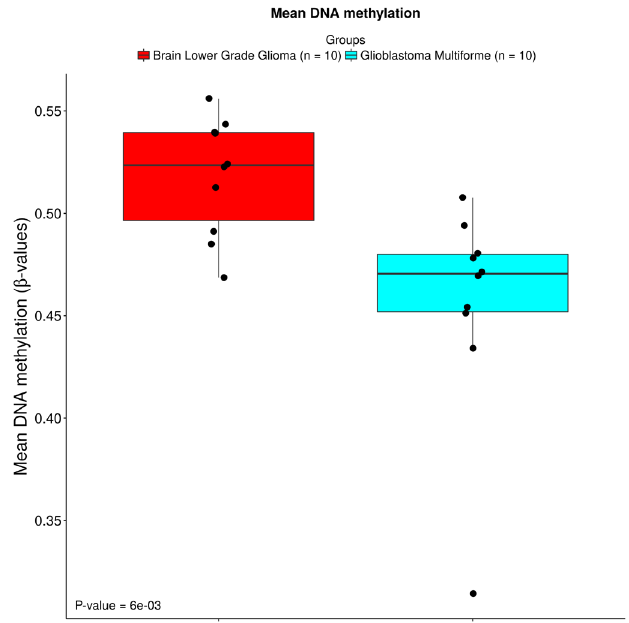
Figure 8. Boxplot of mean DNA methylation of each sample (black